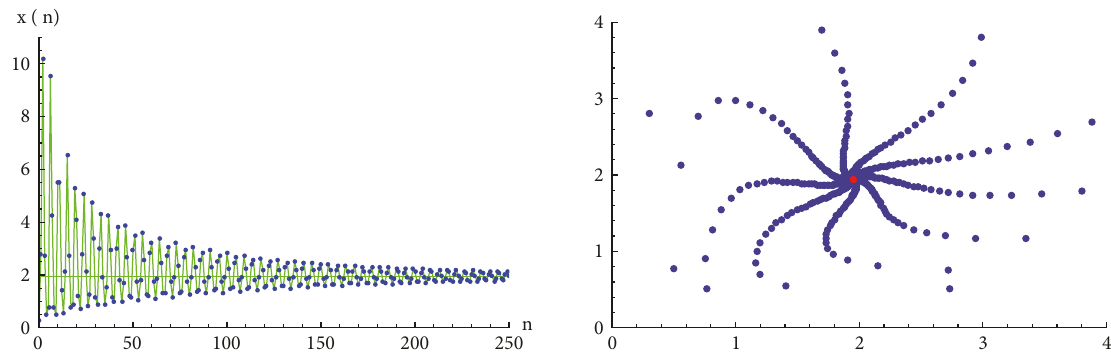
Figure 8: The orbit and phase portrait for 𝑐 = 2,𝑏 = 1,𝐵 = 4 , 𝐹 = 7 , 𝐹 0 = 8 , 𝐹 𝑔 = 128 , and (𝑥 0 , 𝑥 −1 ) = (0.3,2.8) generated by Dynamica 4 [16].